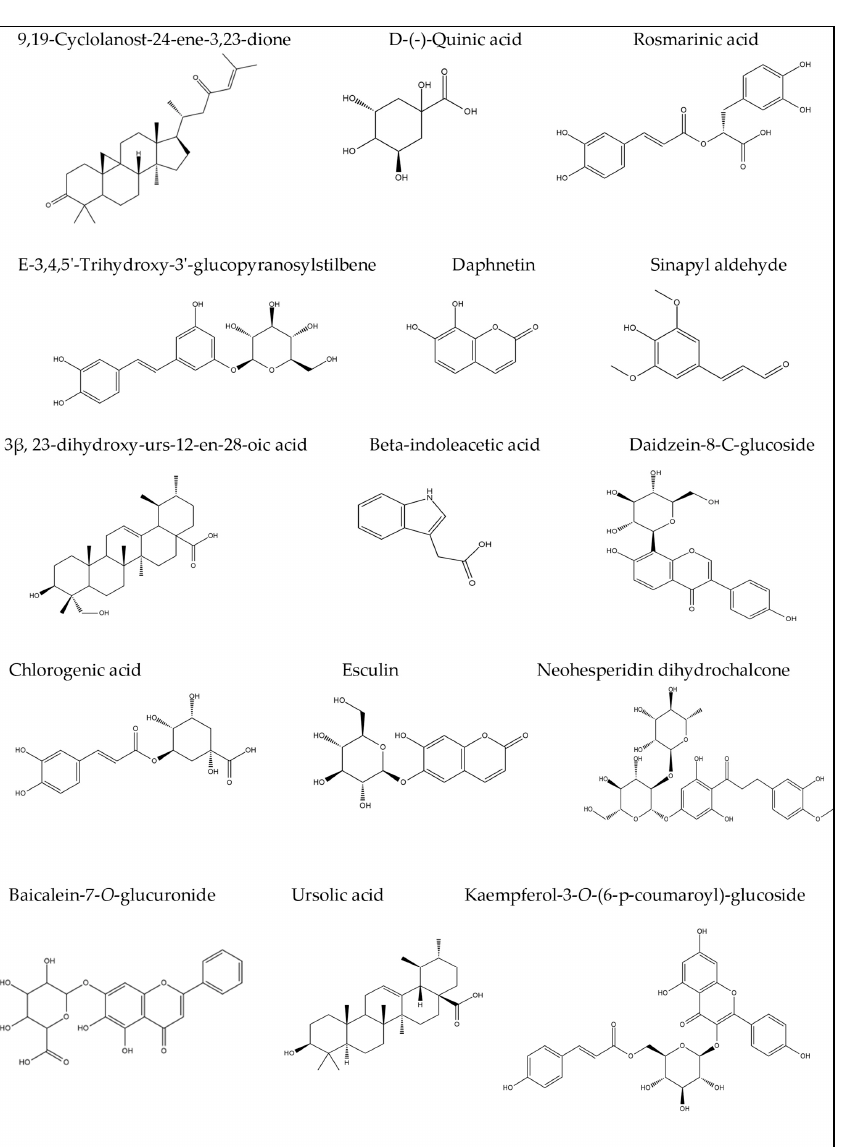
Figure 2. Structures of flavanones and their glycosides.